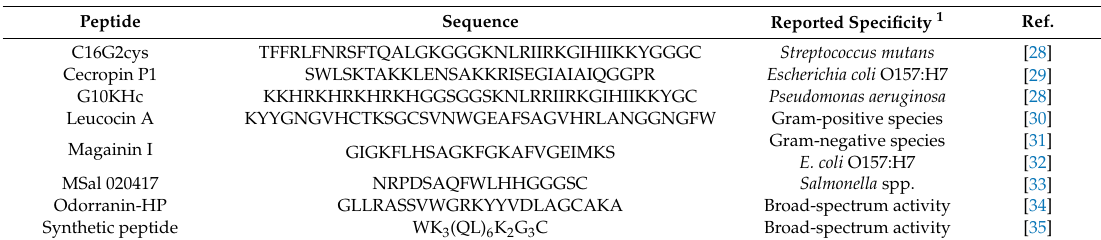
Table 1. Examples of antimicrobial peptides used in biosensors along with their sequences and reported specificities.